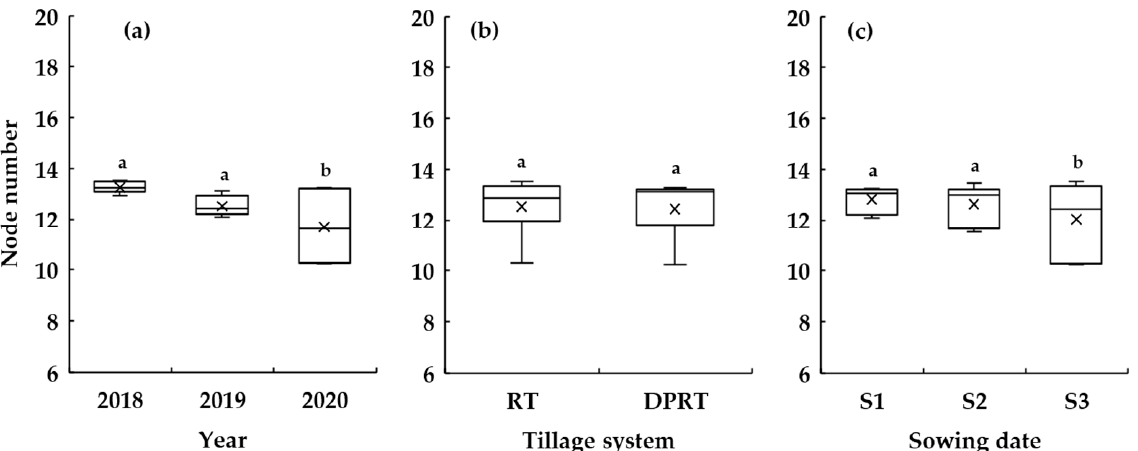
Figure 5. Node number [mean ( × ) and median with 25–75% IQR in boxes] on main stem of double- crop soybean grown in drained paddy fields over three crop seasons ( a ), tillage systems ( b ), and sowing dates ( c ). RT and DPRT refer to rotary tillage and deep plowing followed by rotary tillage, respectively. S1, S2, and S3 refer to sowing date on 10–15 June, 25–30 June, and 10–15 July, respectively. Different letters above boxes indicate statistically significant differences ( p < 0.05).